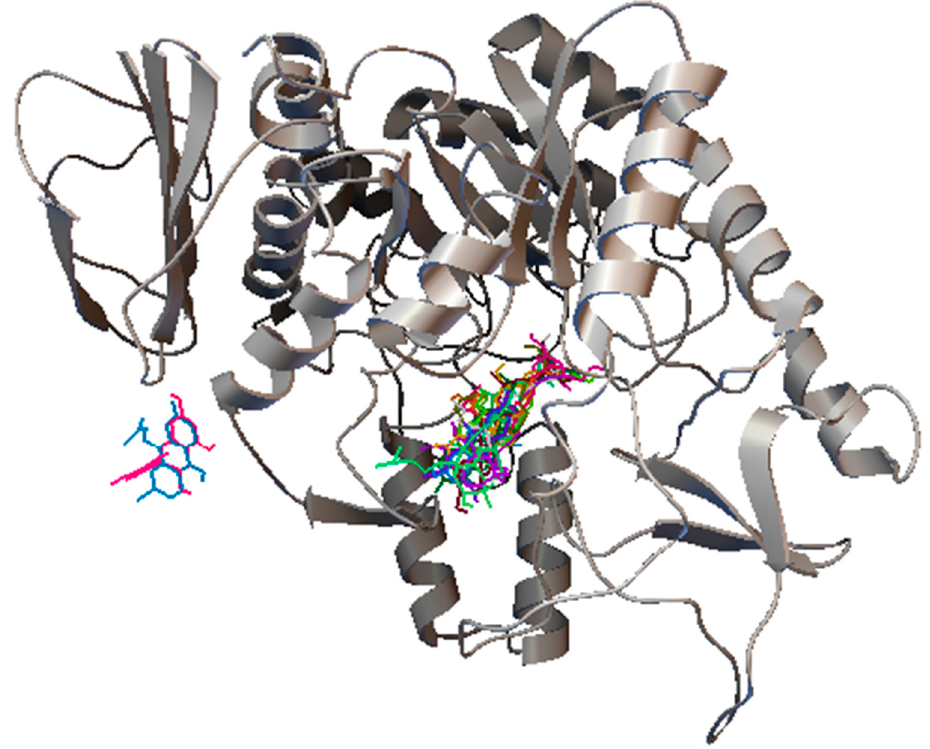
Figure 7. The superimposed 3D diagram showing all the putative active metabolites as well as quercetin, docked into the active site of Saccharomyces cerevisiae isomaltase. The 2 metabolites away from the remaining overlapped metabolites are 5-methoxy-8,8-dimethyl-10-(3-methyl-2-butenyl)-2 H ,8 H -pyrano[3,2-g] chromen-2-one and catechin.